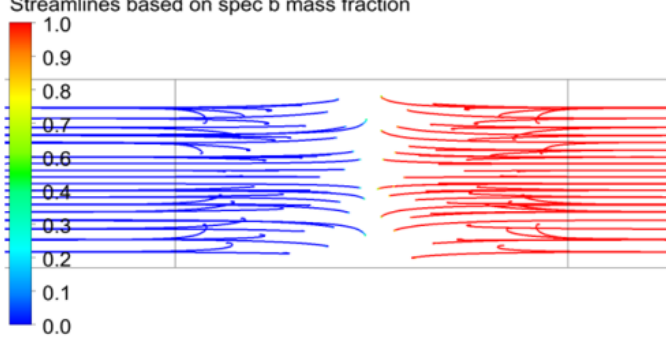
Figure 4. Streamlines at the junction of T-mixer at Re = 66